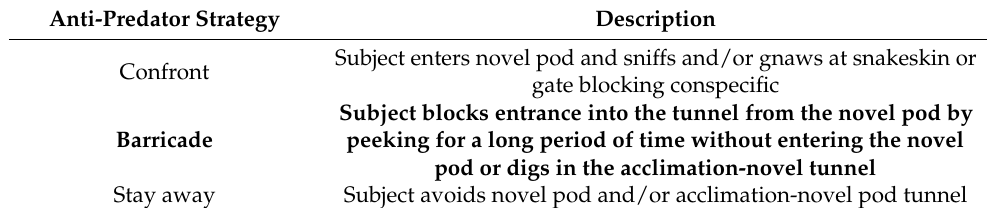
Table 3. Description of observed naked mole-rat response to disturbance behaviors during boldness and aggression